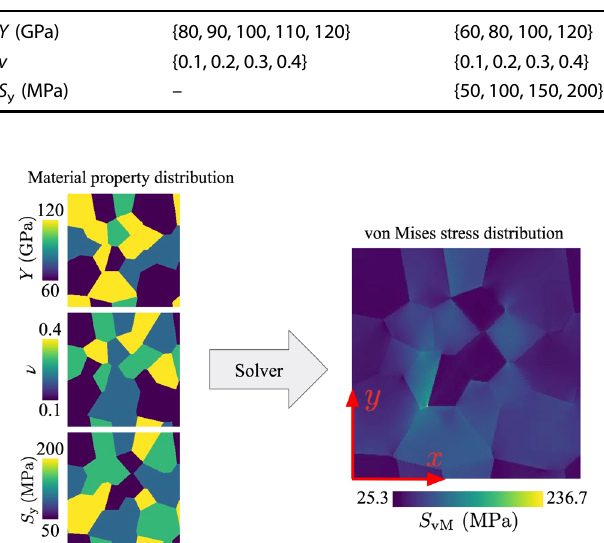
Fig. 7 Schematics of the material property-response relationship. Example of a typical set of maps of an input material property distribution (left) and corresponding output in terms of von Mises equivalent stress distribution (right), calculated with the open- source micromechanical simulation software package DAMASK 8 . The uniaxial tensile load is applied in x direction. The full- fi eld forward simulations serve as training data for the U-Net-based machine learning